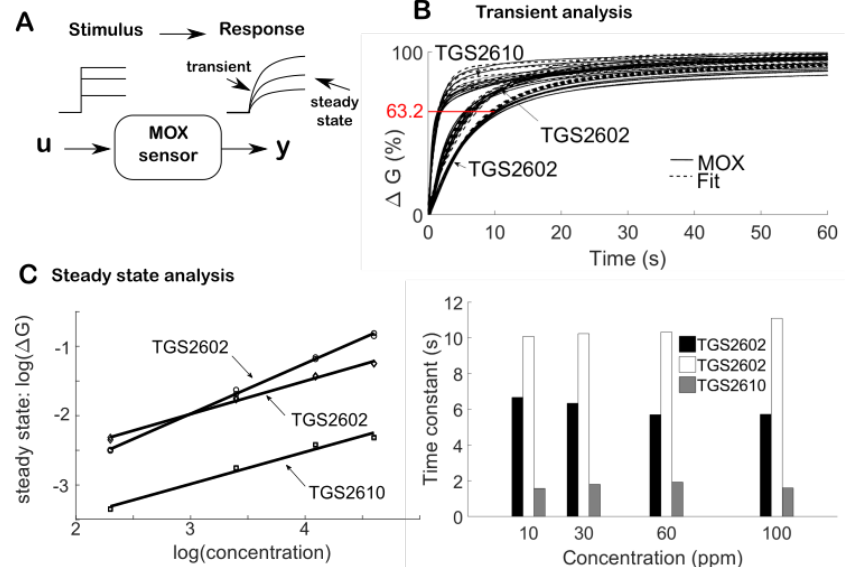
Figure 2. A The step response of MOX sensors. The sensor conductance 𝐺 is measured over time in response to ethanol steps at different concentrations. See Appendix A for details of the experimental setup. B Transient response analysis. Top) The conductance change Δ𝐺 over time in response to a step-like stimulus. The transient is well-fitted by a sum of two exponential functions that represent the adsorption process of the chemical compound onto the sensing element. Here, the time constant corresponds to the time at which the MOX reaches (1 − 1 / e) × 100% ≈ 63.2% of the steady state value. Bottom) The time constant (10.4 ± 0.46 and 6.1 ± 0.47 for the 2 × TGS2602, 1.7 ± 0.19 for the TGS2610 in sec.) depends on the sensor type but is relatively independent on input intensity (ethanol concentration). C Steady state response analysis. The steady-state conductance is well-described by a power law